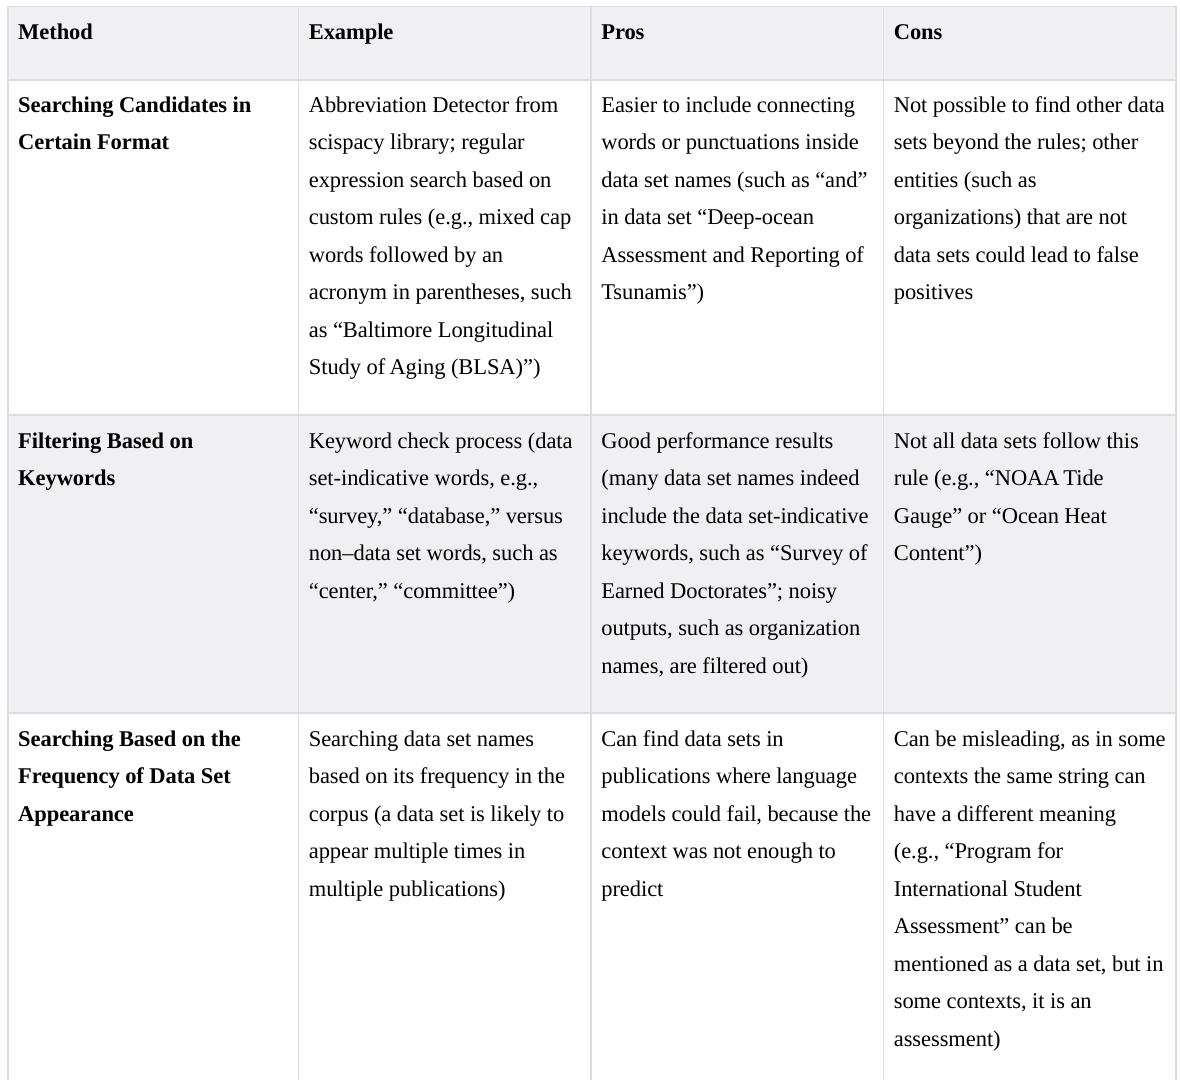
Table 1. Summary of